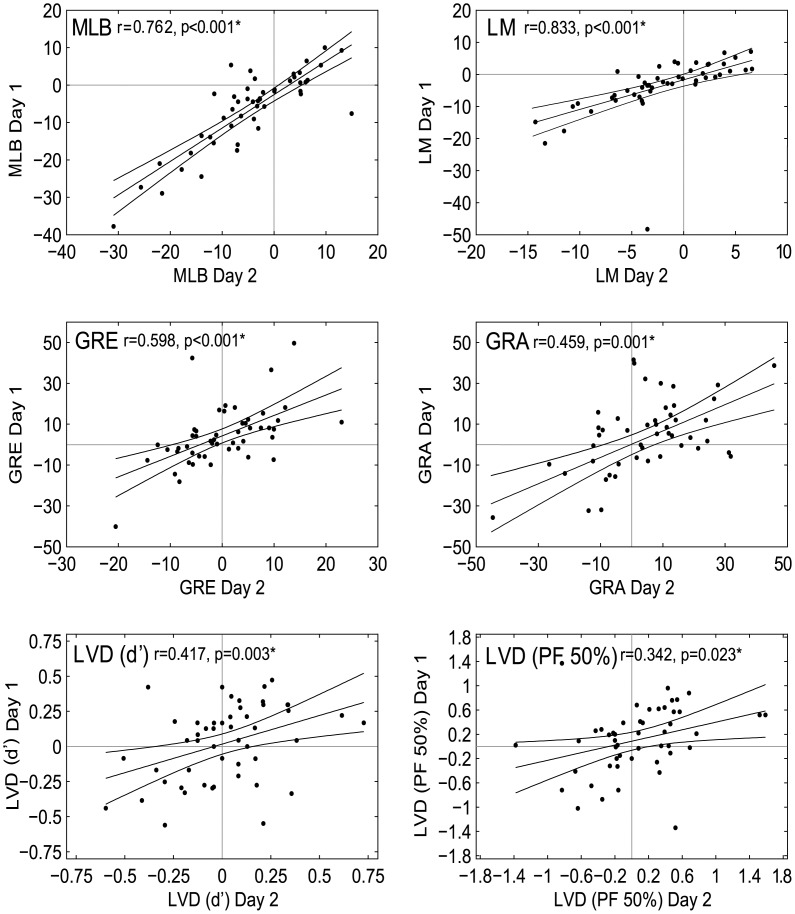
Intra-task correlations.Day 1 vs Day 2 biases are significantly correlated for all 5 tasks (i.e. each task provides a stable measure) over the two testing days (all p-values <0.05). Line of best fit and 95% confidence intervals are marked. * represents a significant correlation at α = 0.05.